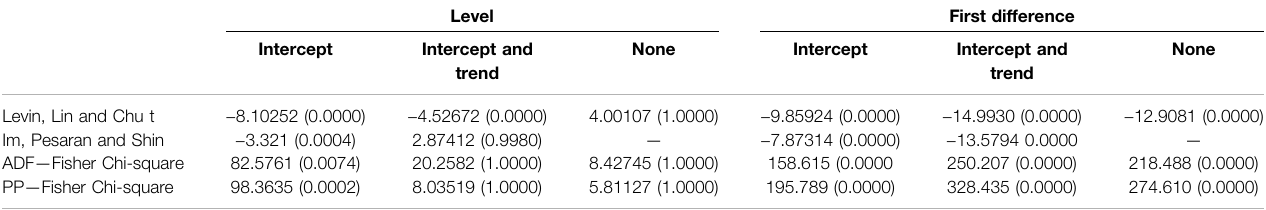
TABLE 1 | Unit root test of GDPCAP variable (GDPCAP).